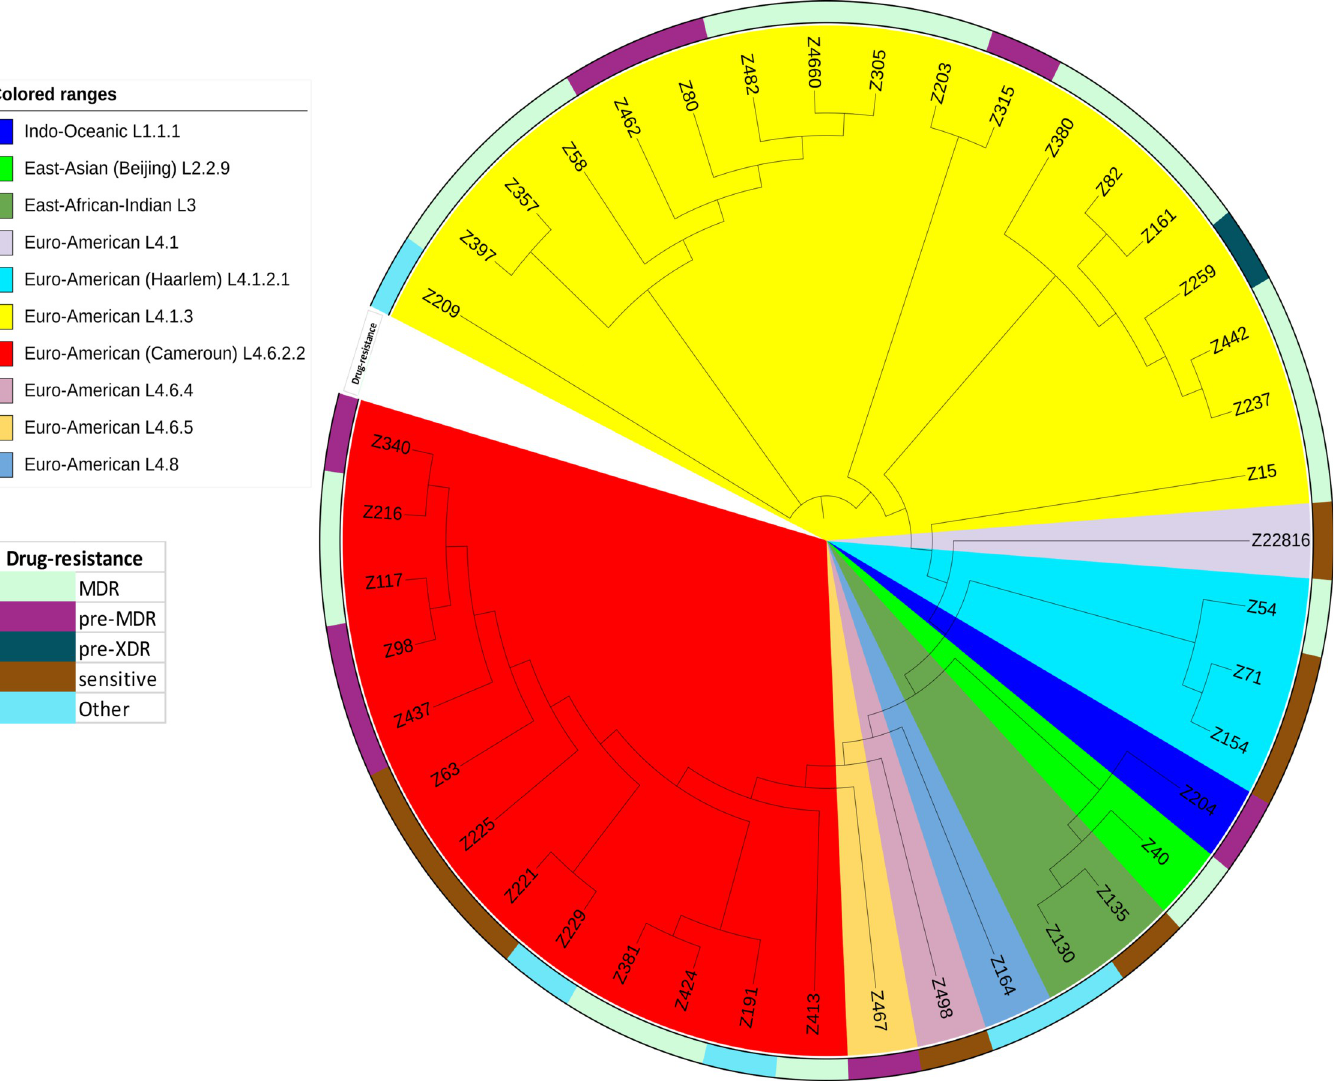
Fig 2. Core genome sequence-based phylogenetic tree displaying the sub-lineages of 42 M . tuberculosis isolates found in Niger. The colours of the isolates represent the resistance drugs of the sub-lineages. Phylogenetic trees based on the core genome were generated using FastTree 2.1.10_1 software (https://ngphylogeny.fr/tools/tool/ 271/form) using GTR model and bootstrap option with 1000 replicates. Tree was visualized using the iTOL online website.